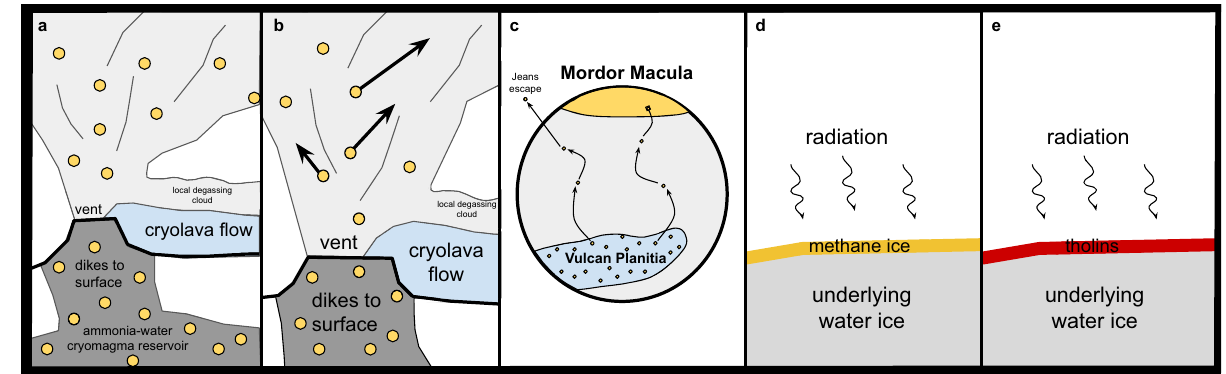
Fig. 1 Diagram of how methane particles travel to Charon ’ s pole. a , b Methane (represented by yellow circles) is expelled from the subsurface through the eruption of a cryo fl ow onto Charon ’ s surface, where particles migrate across the surface with varying velocities and trajectories. c Some methane particles will migrate to Charon ’ s pole, where they become seasonally cold-trapped. Some fraction of particles will be lost from the system after reaching Charon ’ s escape velocity. d Methane ice is cold-trapped at Charon ’ s pole and begins to be processed. e Methane cold-trapped at the pole is processed over Charon ’ s winter to less volatile products that will not sublimate away during Charon ’ s summer. Over geologic time, these less volatile methane products at Charon ’ s pole will be processed by radiation from various sources into tholins, creating the red region we observe today as Mordor